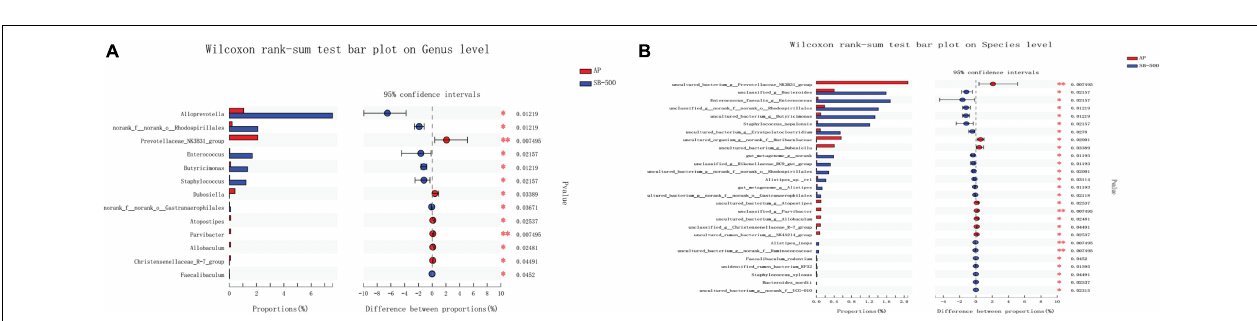
FIGURE 8 | Analysis of gut microbiota species difference at the genus and species levels in the AP vs. Sham group. At the (A) genus and (B) level. On the left, the X and Y axes represent the average relative abundance of the gut microbiota species in various groups and the gut microbiota species names at a certain classification level, respectively. On the right, the X and Y axes represent different gut microbiota species between various groups and p -value of significance. ∗ 0.01 < p < 0.05. ∗∗ 0.01 < p < 0.001. Sham, Sham operation group; AP, acute pancreatitis group.